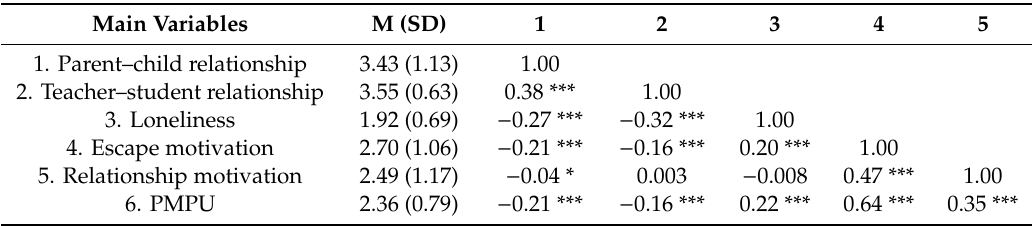
Table 1. Means, standard deviations and correlations among main